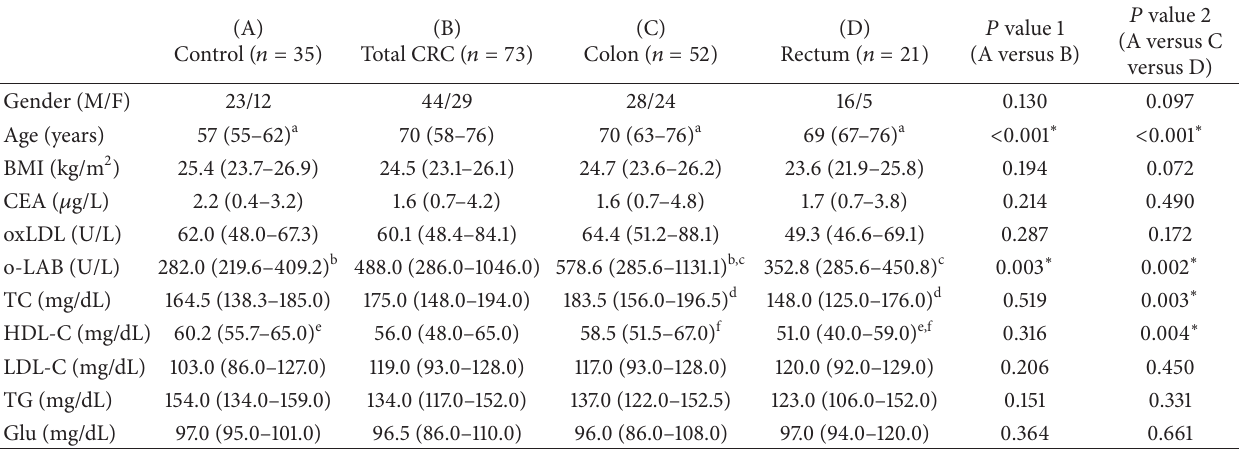
Table 1: Demographic, clinical, and biochemical parameters in healthy control and total CRC patients and in colon and rectum subgroups. Data are presented as median (interquartile range Q25–Q75).